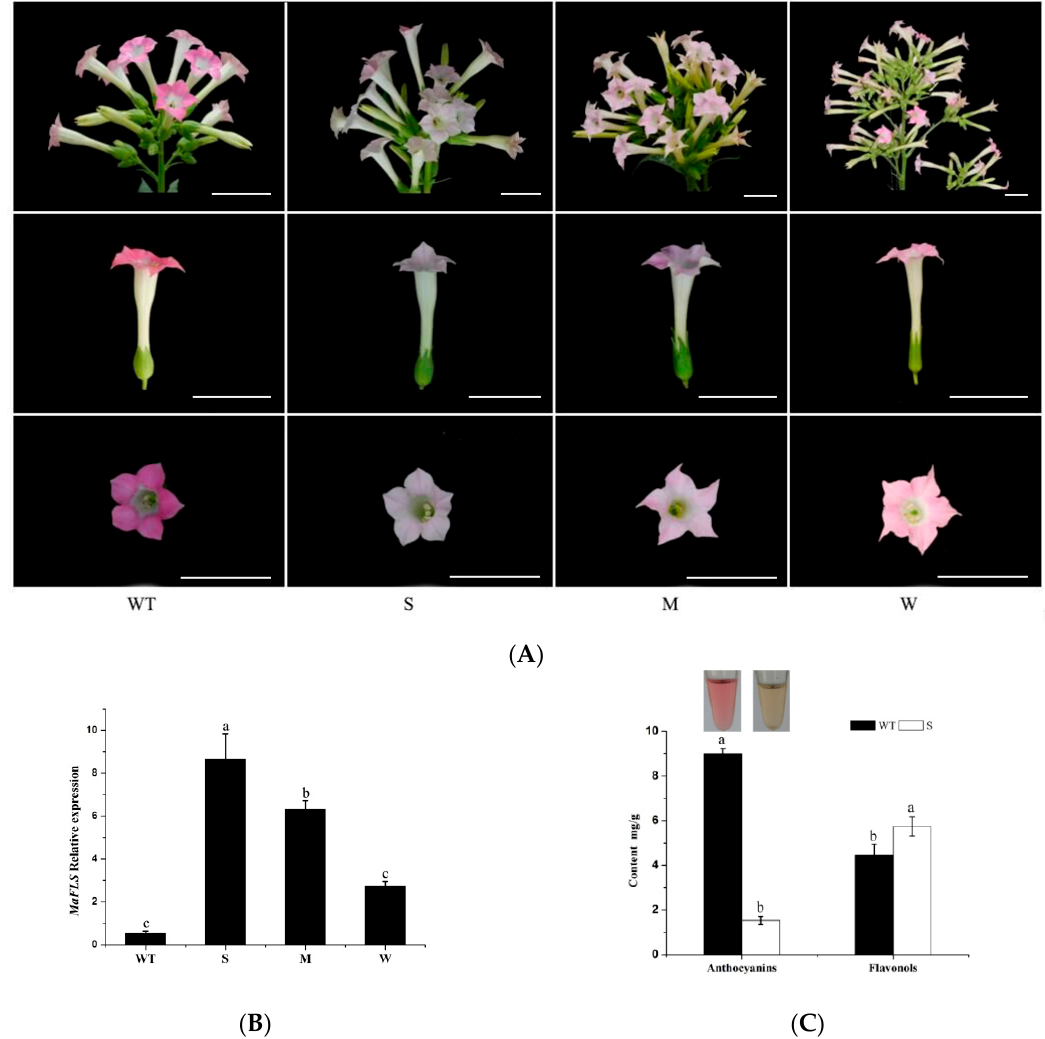
Figure 5. Changes in tobacco flowers induced by heterologous expression of MaFLS. ( A ) Heterologous expression of MaFLS in transgenic tobacco flowers resulted in a clear phenotypic change in petal coloration. Shown are non-transformed controls (WT) and three MaFLS -expressing lines exhibiting different phenotypic characteristics (S, strong; M, medium; W, weak). Bars, 5 cm. ( B ) qRT-PCR analysis of MaFLS relative expression levels in the petals of three independent transgenic tobacco lines. NtTubA1 was used as the internal expression control. ( C ) The color of the extractions is shown in the centrifugal tubes. HPLC analysis of anthocyanin and flavonol levels in tobacco petals in mg / g fresh weight (FW) of the non-transformed control (wild type, WT) and the transgenic line with a strong phenotype (S). Each column represents means ± SD from three technical replicates. Different letters above the bars indicate significantly different values ( P < 0.05) calculated using one-way ANOVA followed by Duncan’s multiple range test.